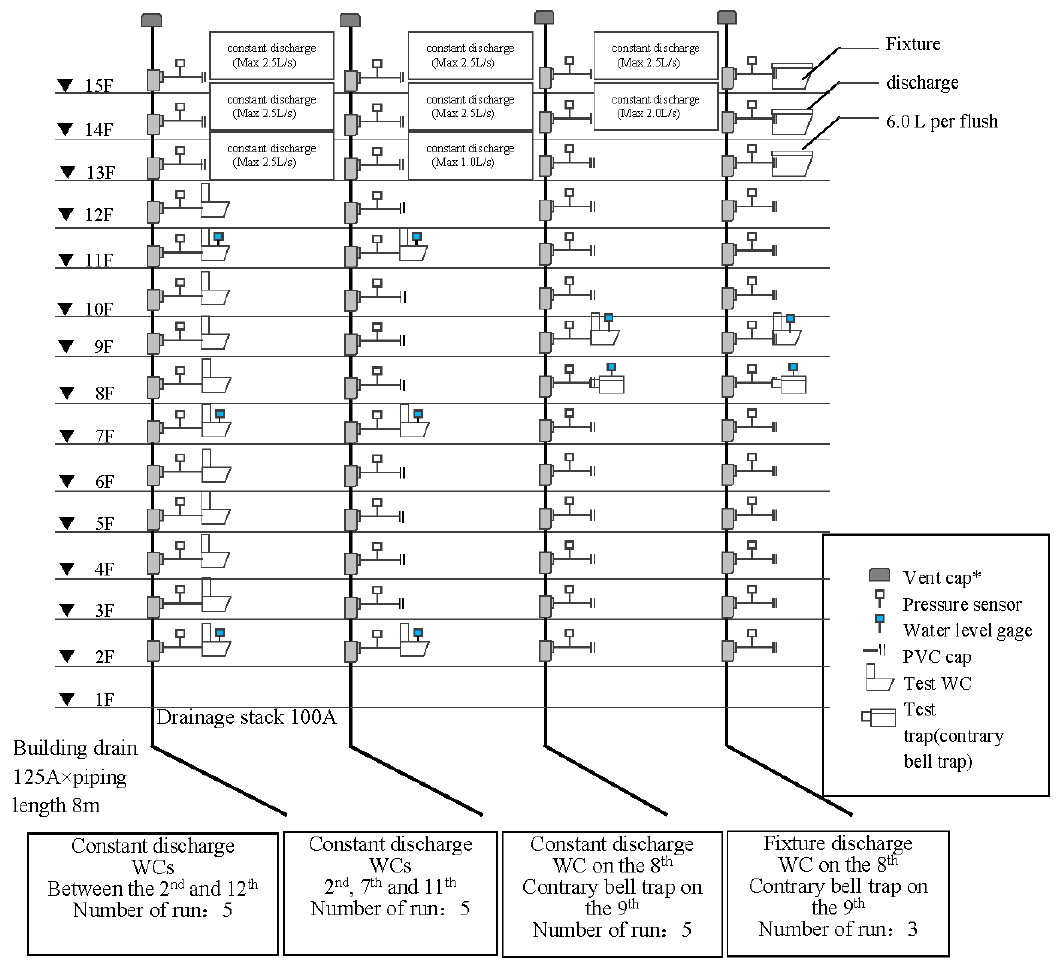
Figure 1 . Outline of the experimental drainage system. Figure 1. Outline of the experimental drainage